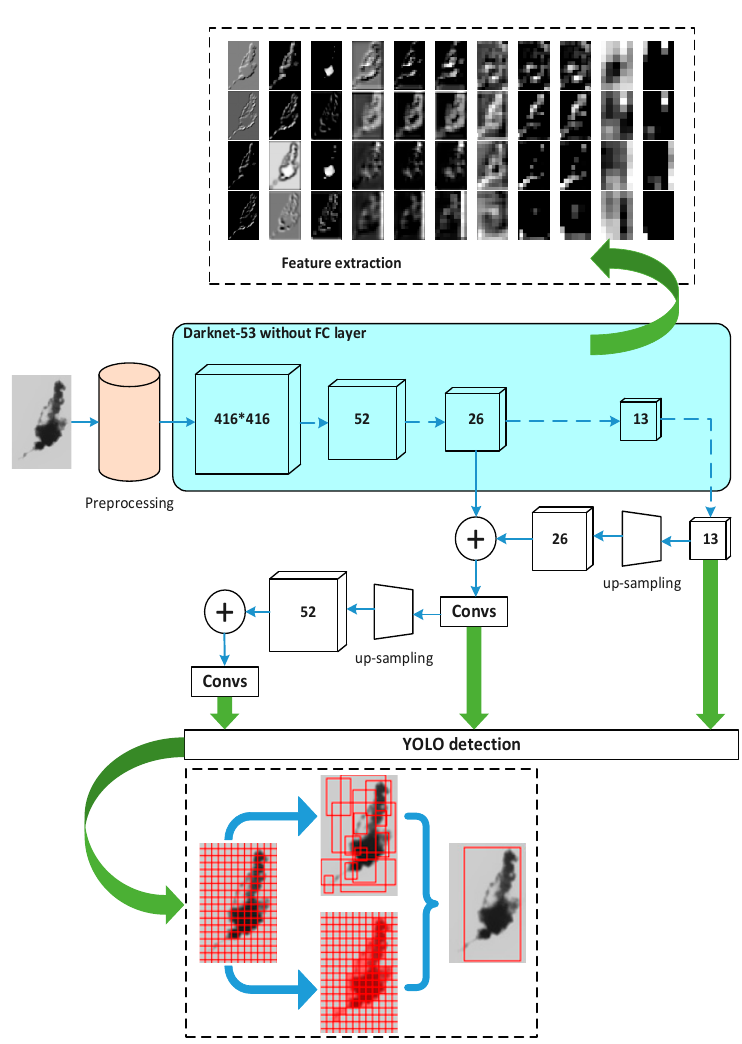
Figure 18. Schematic diagram of YOLOv3 network structure for impurity detection. Table 3. Experimental results of the algorithm in this paper, KNN and